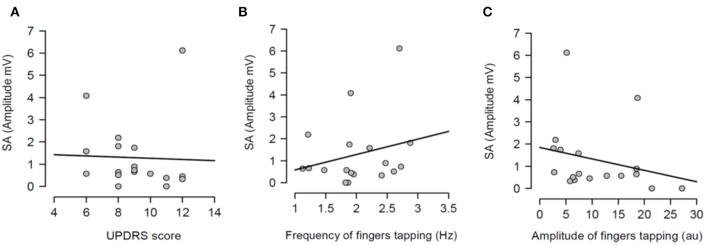
Regression analysis between sensory attenuation (SA) and measures of bradykinesia [UPDRS score (A), frequency of fingers tapping (B) and amplitude of fingers tapping (C)] in PD patients in OFF state.